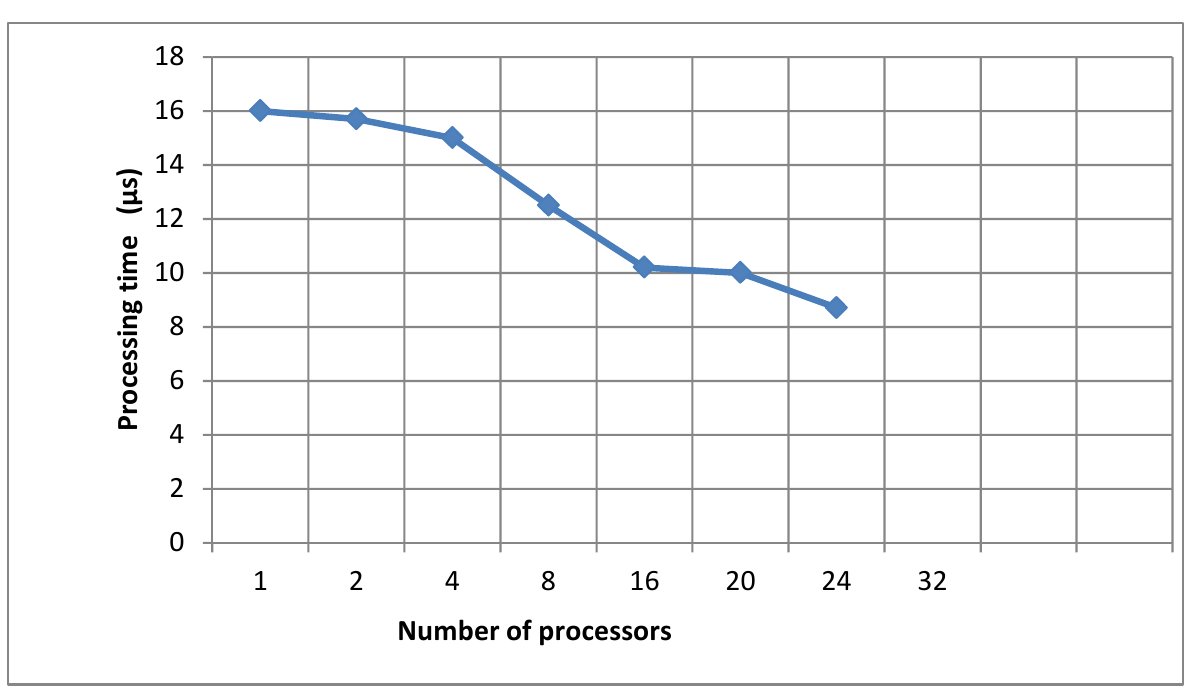
Figure 8. Dependence of SVD processing time on the number of computing processors at 20 × 20 matrix size.